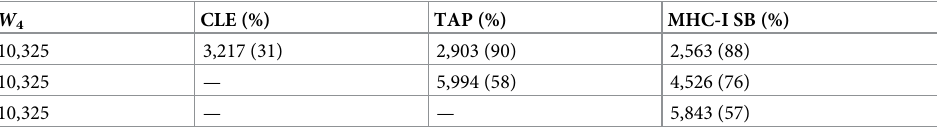
Table 4. Numbers of unique peptides and percentages for Trypanosoma cruzi related to selection steps: Protea- some cleavage (CLE) higher than or equal to 0.5, TAP transport (TAP) higher than or equal to 0 and MHC-I bind- ing (MHC-I SB) smaller than or equal to 0.5 for W 4 .